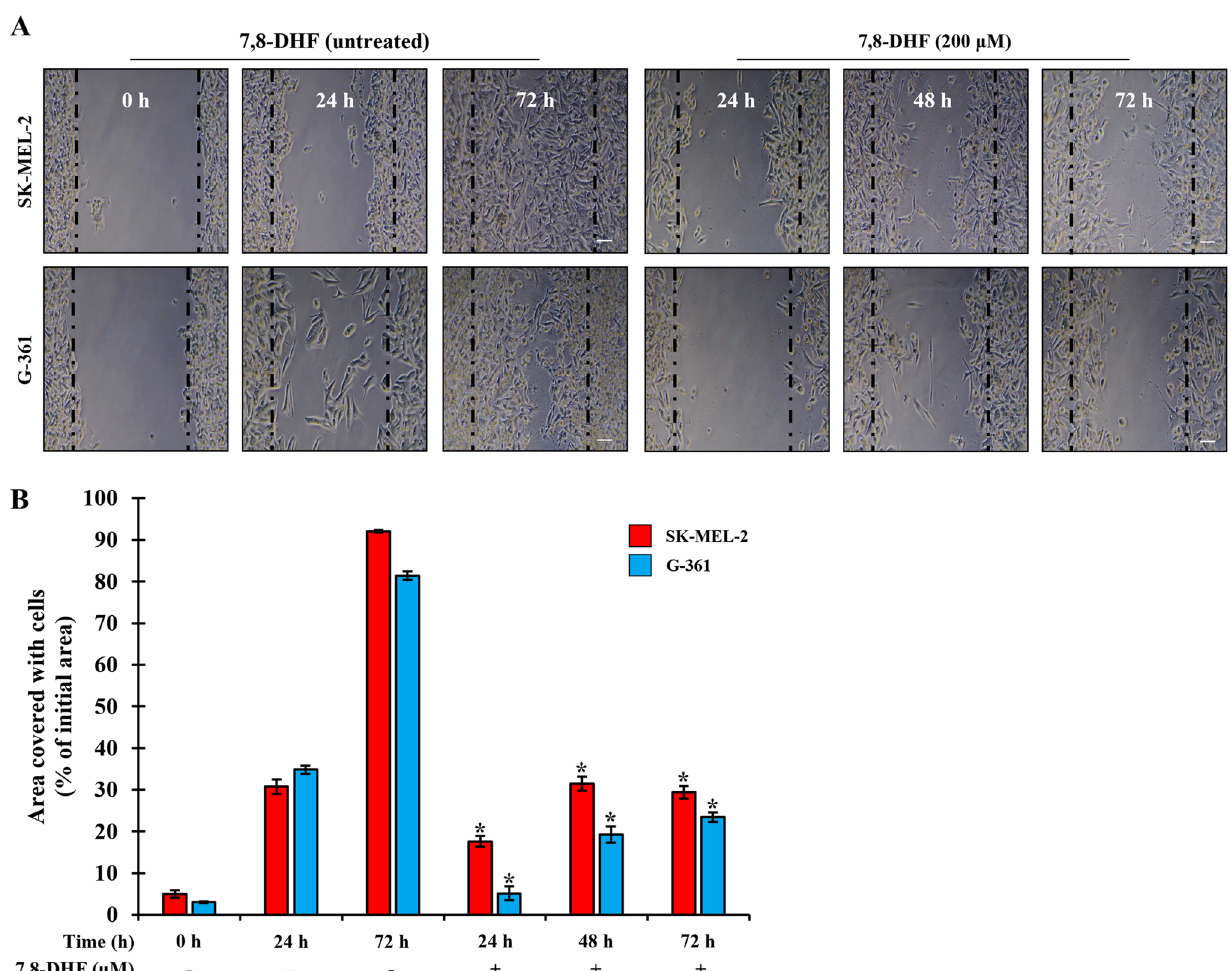
scratched using sterile pipette tips and then incubated with or without (control group) 7,8-DHF. Samples were observed under a light micro- scope at 24, 48, and 72 h. B The area covered with cells was quantified. Red square and blue square represent SK-MEL-2 and G-361 cells, respectively. All data were presented as the mean ± SD ( n = 3, * p <